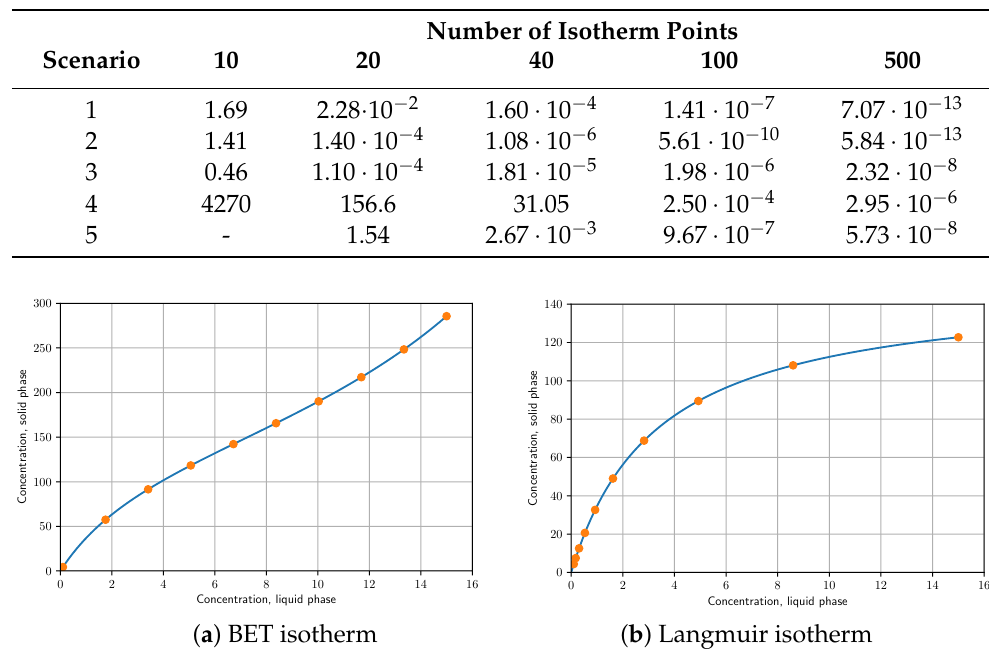
Table 1. SSR values for each scenario for different numbers of isotherm points.